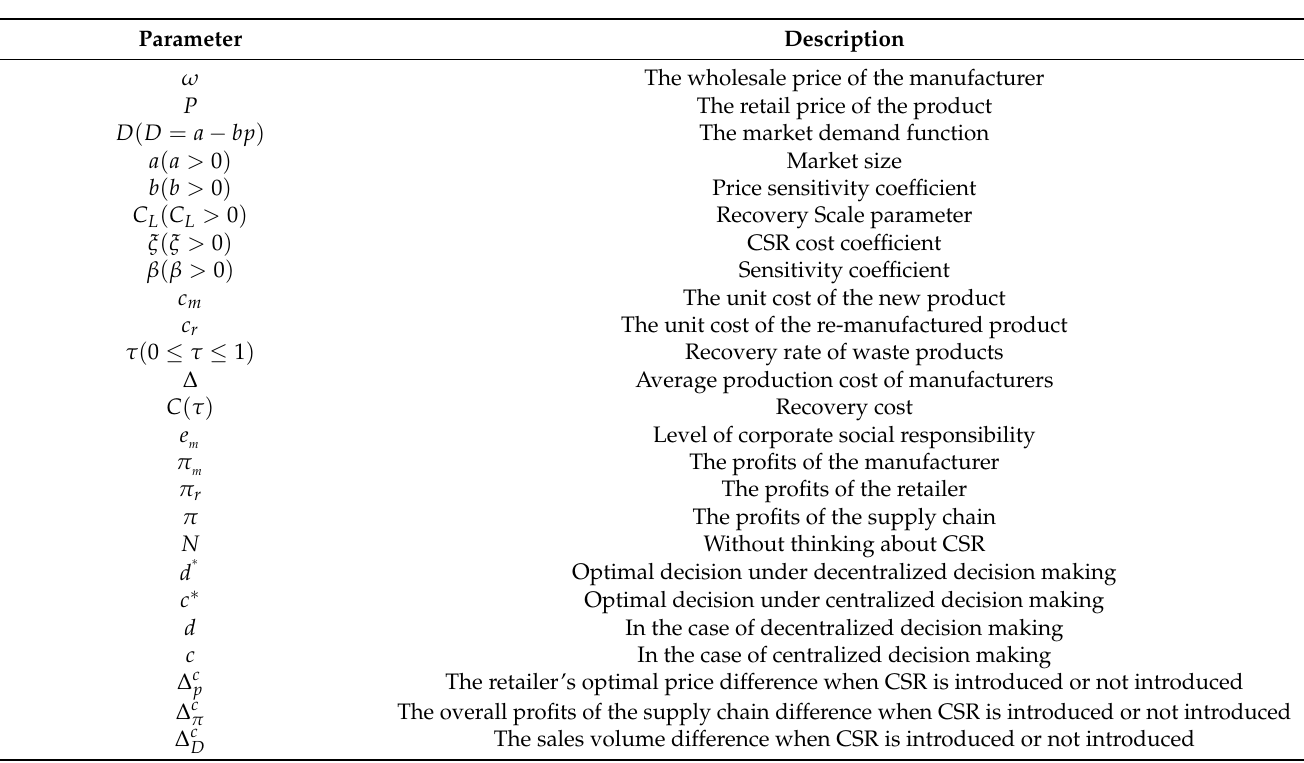
Table 1. Parameter description of the